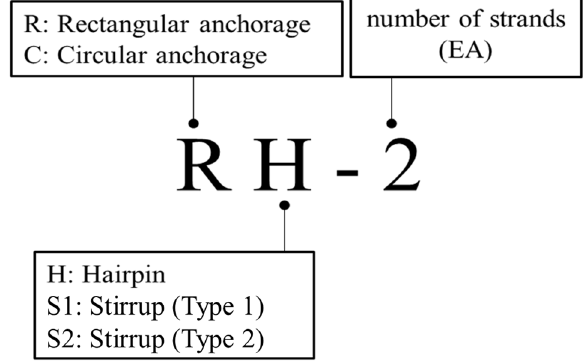
Figure 2. Notations of specimens.